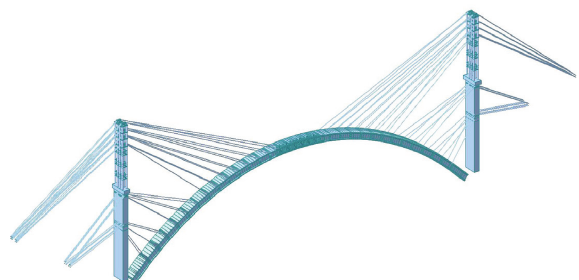
Figure 21: Finite element model of the Yelang Lake Bridge.